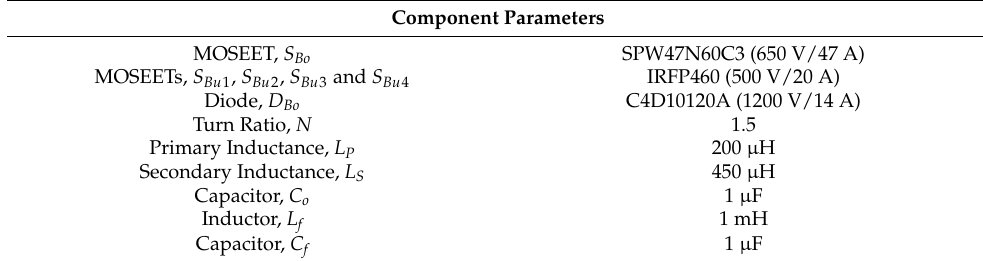
Table 3. Component parameters of the proposed high-gain inverter.